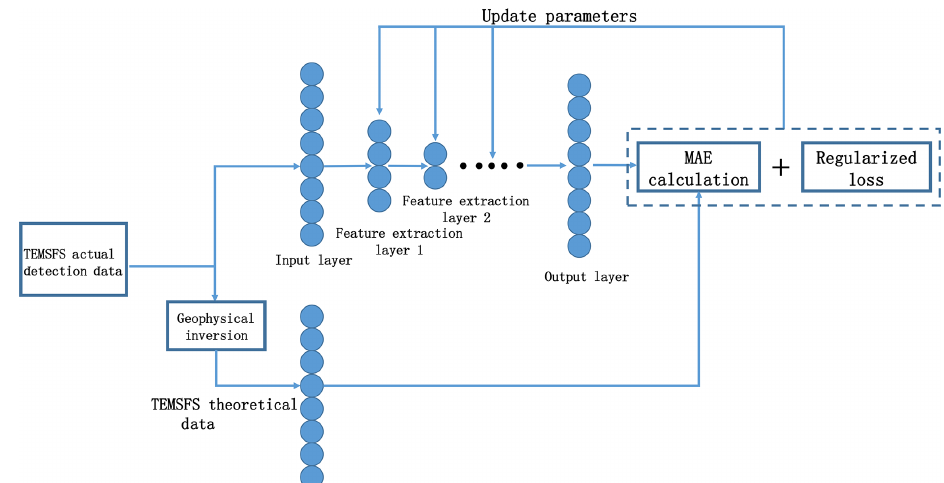
Figure 1. The flow chart of the model. Total loss is the sum of the mean absolute error (MAE) calculation and regularization loss. The MAE calculation is the difference of the theoretical signal and output. The regularization loss is calculated by the L2 function. Autoencoders (AEs) are trained one by one and then fine-tuning is used.